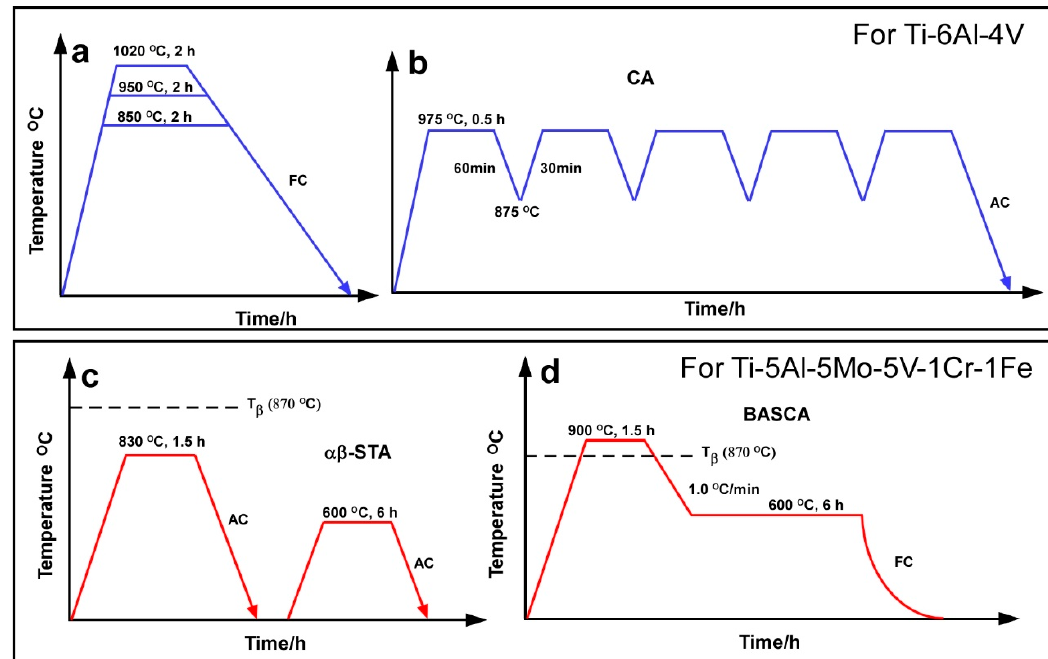
Figure 2. Schematic of post-heat treatment: ( a ) solution treatment followed by furnace cooling (FC) for Ti64, ( b ) cyclic annealing (CA) for Ti64 [25], ( c ) solution treatment in the α + β phase field followed by aging ( αβ -STA) for Ti55531 and ( d ) beta annealing followed by slow cooling and aging (BASCA) for Ti55511.